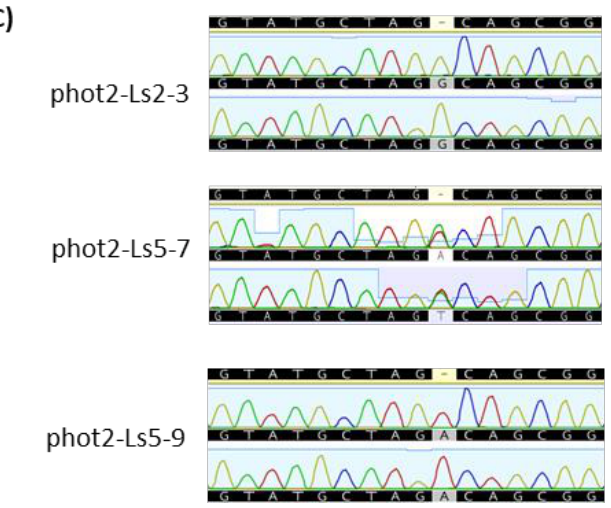
Figure 4. Screening of germline transmission of phot2 mutations without transgene in R1 phot2-Ls lines. ( A , B ) Isolations of stable phot2 mutant lines without transgene from the phot2-Ls in the R1 generation. phot2-Ls2-3 ( A ) and phot2-Ls5 ( B ) were selected as the representative lines of monoallelic and biallelic mutants, respectively. Nhe 1 digestion (upper panel): Nhe 1 digestions of PCR products to detect indel mutations at the sgRNA361 targeting site. Other details are the same as those shown in Figure 3A. Transgene detection (lower panel): PCR products for transgene using a Cas9-specific primer set (see Figure 2A). Note that the lines phot2-Ls2-3, phot2-Ls5-7, and phot2-Ls5-9 are resistant to Nhe I digestion and have no transgene. ( C ) Sequence-based detection of phot2 mutations in R1 phot2-Ls2 and phot2-Ls5 lines. Other details are the same as those shown in Figure 3B. phot2-Ls2-3 and phot2-Ls5-9 lines in the R2 generation were further confirmed for the safe transmittance of mutations and the phot2 mutant phenotype. Analyses of PCR/RE digestion and PCR-based transgene detection and DNA sequencing consistently suggested that the phot2-Ls2-3 and phot2-Ls5-9 lines were transgene-free and homozygous, harboring one nucleotide insertional mutation (guanine or adenine nucleotides) in the first exon of the PHOT2 gene, which was safely transmitted from the R0 to R2 generations (Figure 5A–C). Consistent with genotypic analysis, the phot2-Ls2-3 and phot2-Ls5-9 lines were specifically defective in the chloroplast avoidance response as well as in dark positioning but were nor- mal in the chloroplast accumulation response, as previously described in the Arabidopsis phot2 mutant (Figure 5D,E;